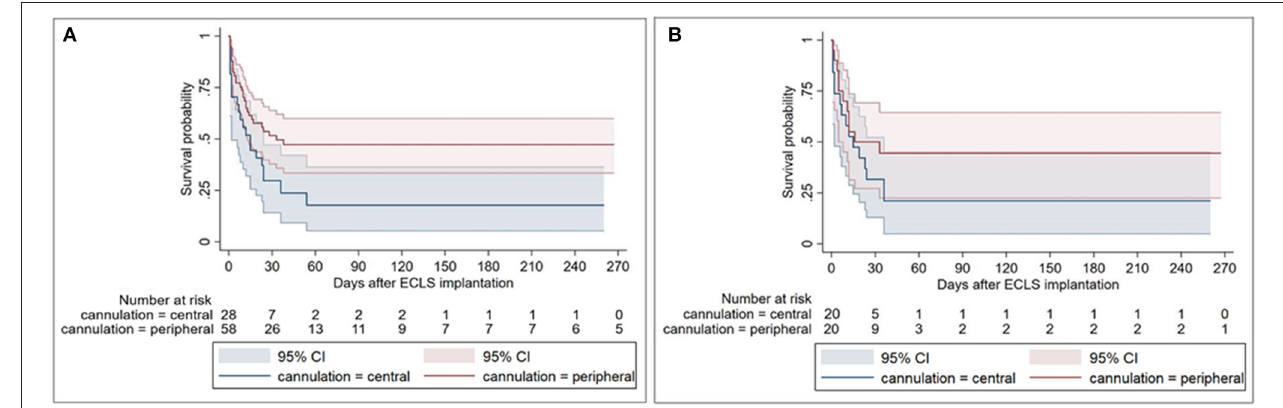
FIGURE 1 | Kaplan–Meier survival curves depicting impaired survival in central compared to peripheral cannulation for postcardiotomy extracorporeal life support (ECLS) (A) , which attenuates after risk adjustment by propensity score matching (B) . The survival difference occurs early after surgery and is maintained in the later postoperative